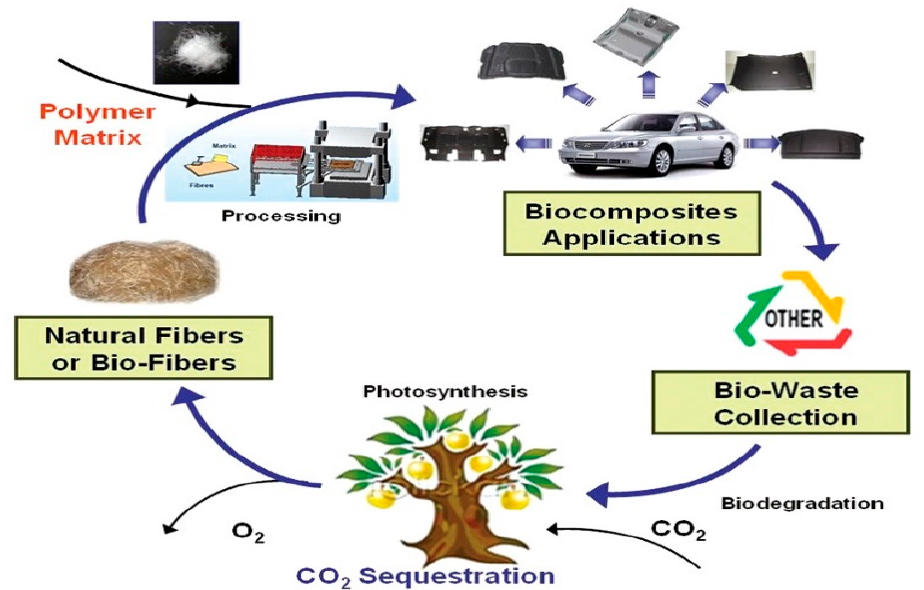
Figure 2. Natural life cycle of a natural fiber and biocomposite part [5].